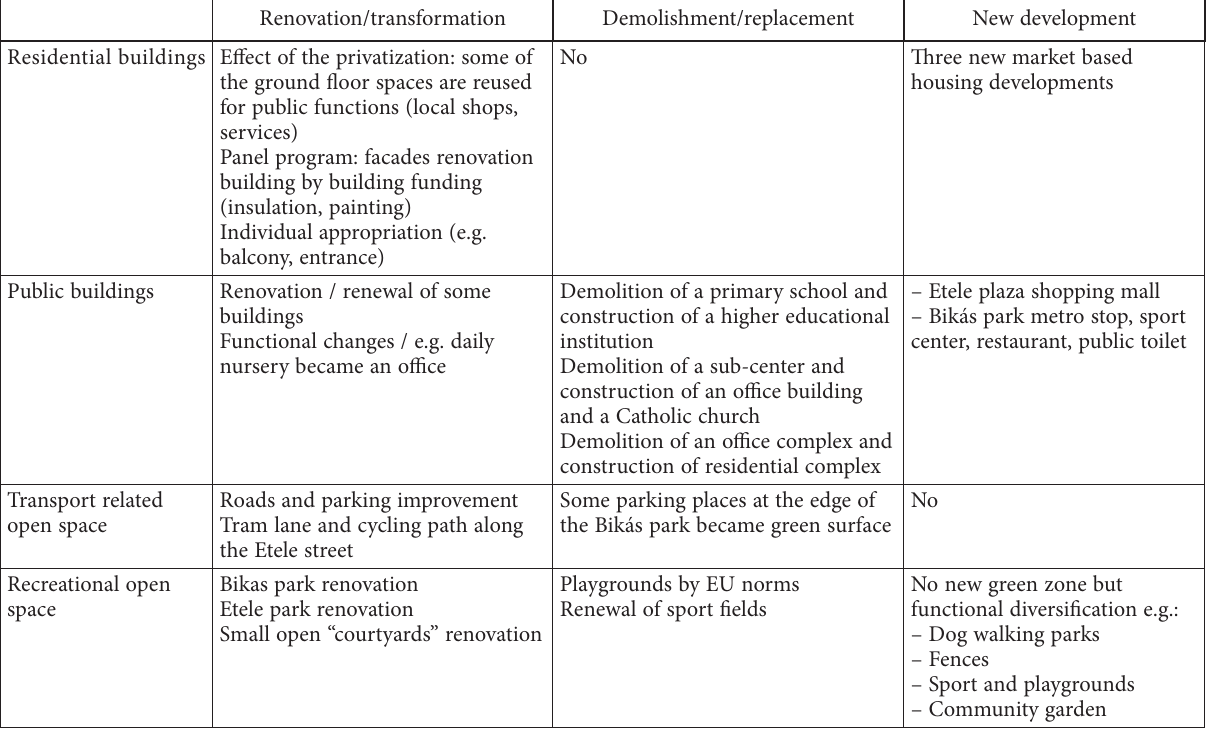
Table 2. Types of architecture and urban transformations in Kelenföld LHE (source: author, 2022) Renovation/transformation